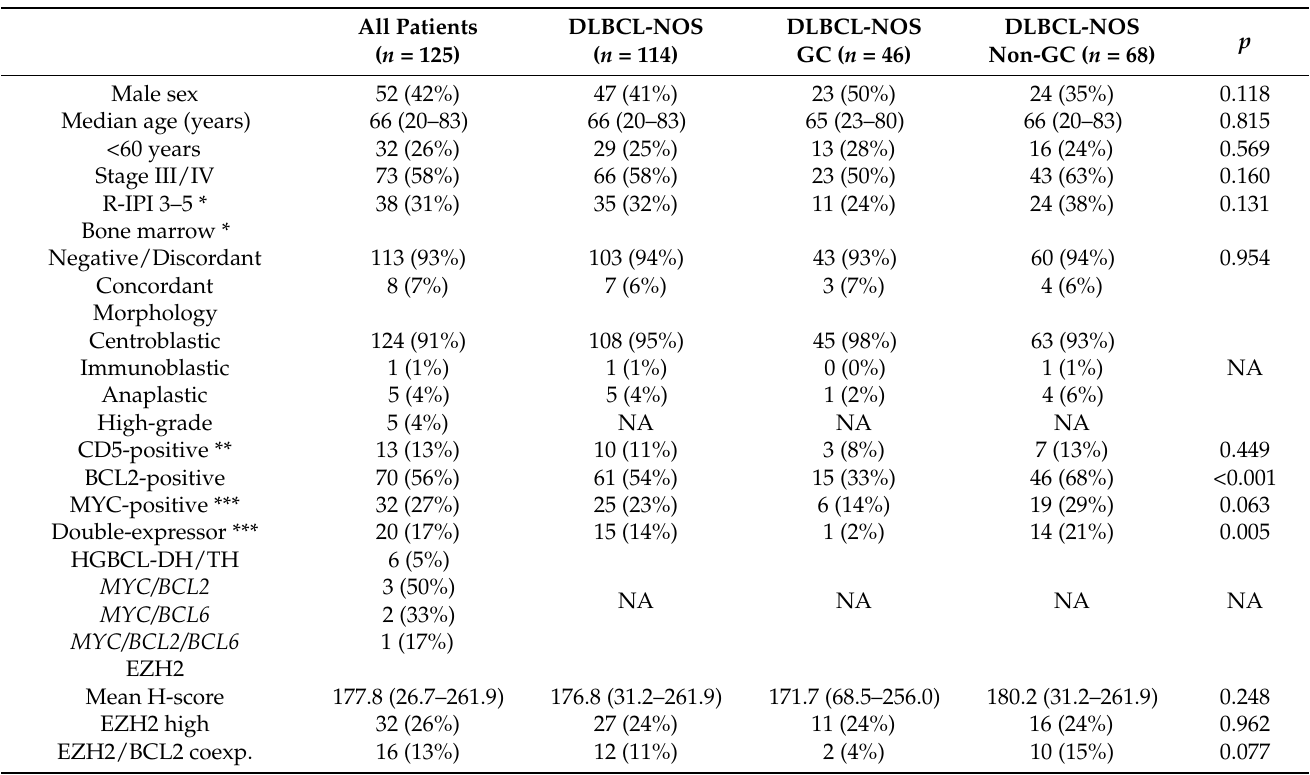
Table 1. Baseline characteristics of the study cohort ( n = 125).